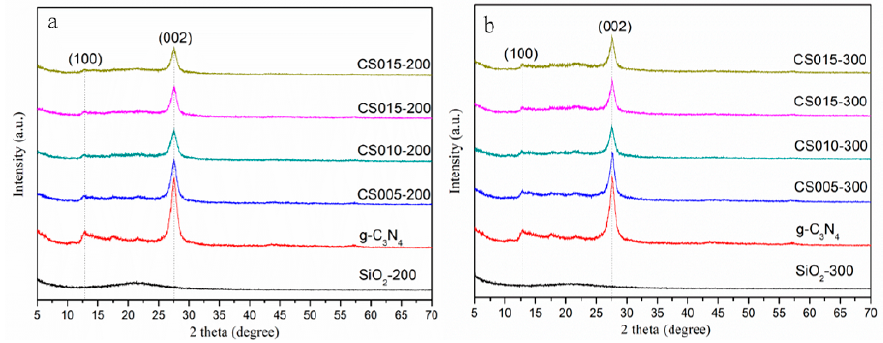
Figure 1. The XRD patterns of SiO 2 -200, g-C 3 N 4 , CS005-200, CS010-200, CS015-200, CS020-200 ( a ) and SiO 2 -300, g-C 3 N 4 , CS005-300, CS010-300, CS015-300, CS020-300 ( b ).